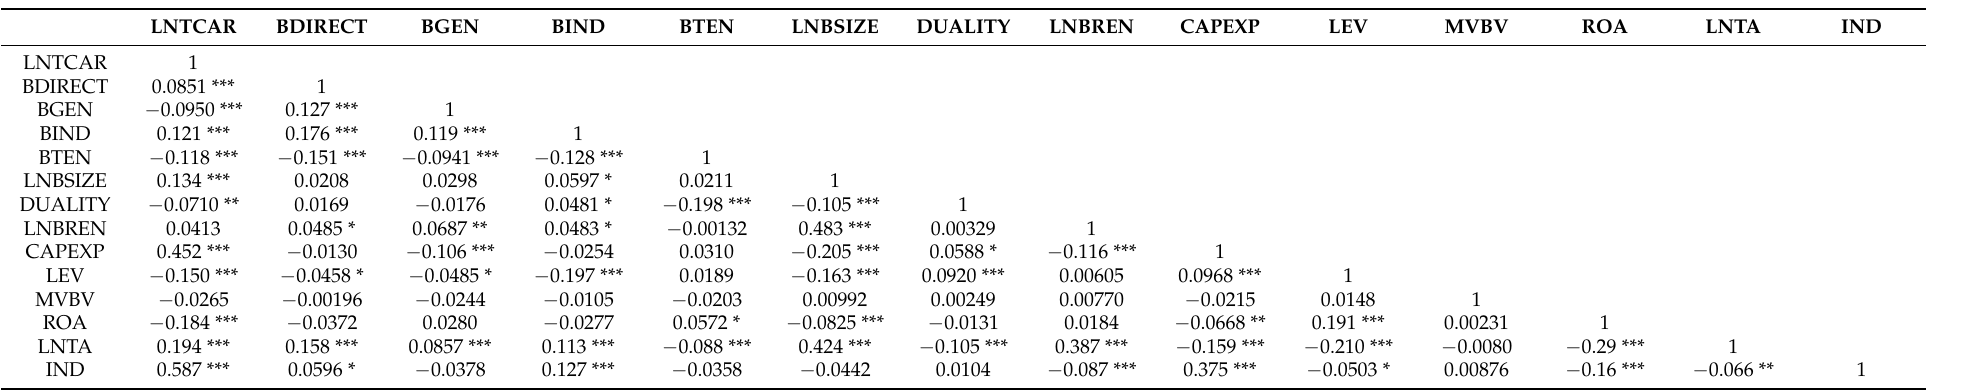
Table 2. Correlation